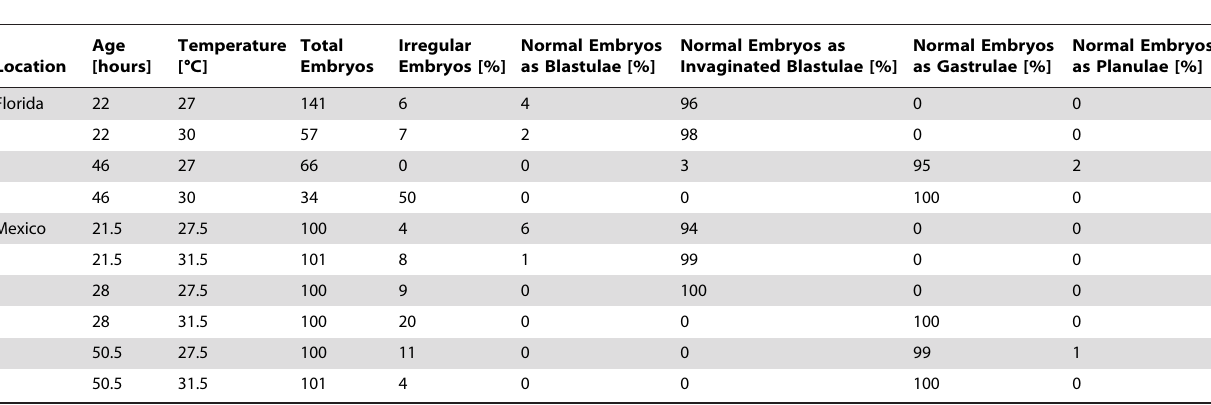
Table 1. Percentages of M. faveolata embryos in various stages of development at control and treatment temperatures from Mexico and